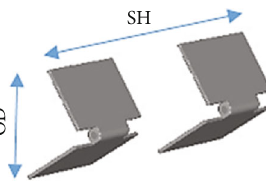
Figure 12: Geometric parameters of the airfoil arrangement used to calculate the characteristic width “ CW.